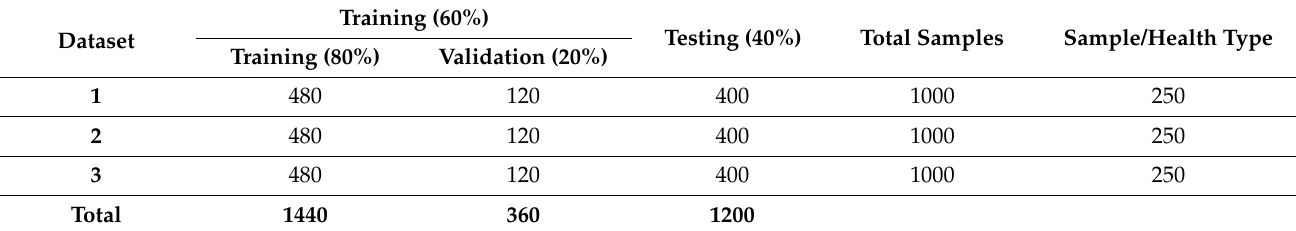
Table 6. The training, testing, and validation dataset ratios.